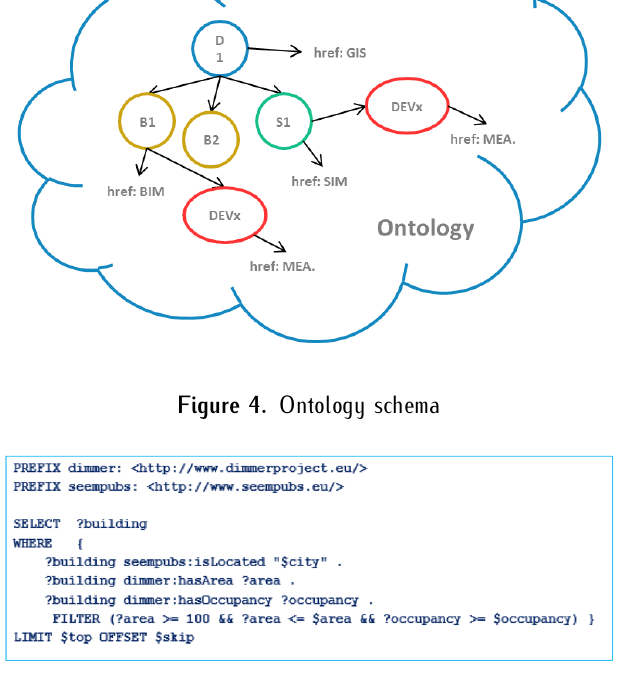
Figure 5. Parametrized SPARQL